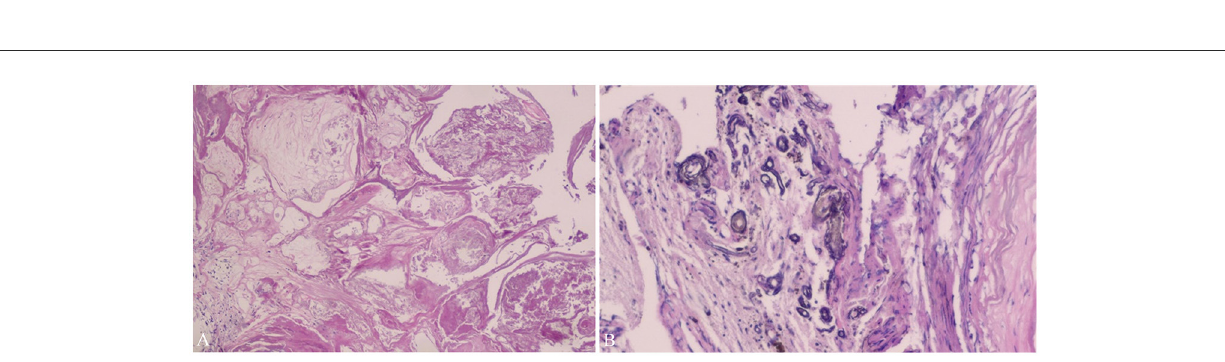
FIGURE3 Pathological findings of Case 11. Pathological findings (Case 11) show vascular tissues of different sizes (A) and calcification (B) , which confirm the diagnosis of cavernous hemangioma (hematoxylin–eosin staining × 20). It has been demonstrated in Neurosurgical Focus Video— Anterior endoscopic transcortical approach to a pineal region cavernous hemangioma